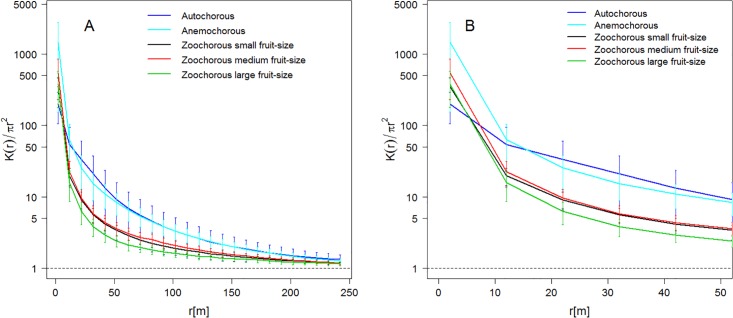
Spatial aggregation by syndrome.The spatial aggregation statistic K(r)/πr2 ±1 Standard Error, evaluated each 10 m, up to r = 250 m (A) and up to r = 50 m (B). The dotted line indicates the values of the spatial aggregation statistic for a Poisson random spatial distribution. A species is aggregated at distance r if K(r)/πr2 > 1. Zoochorous small fruit-size (< 2 cm), Zoochorous medium fruit-size (2–5 cm), Zoochorous large fruit-size (> 5 cm).